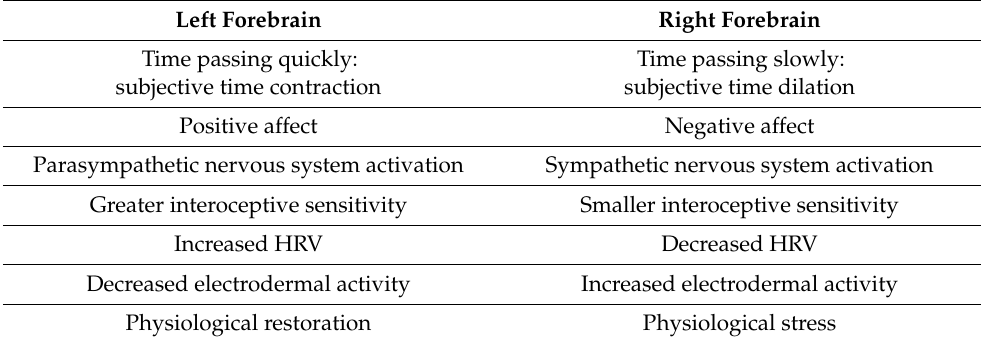
Time passing slowly: subjective time dilation